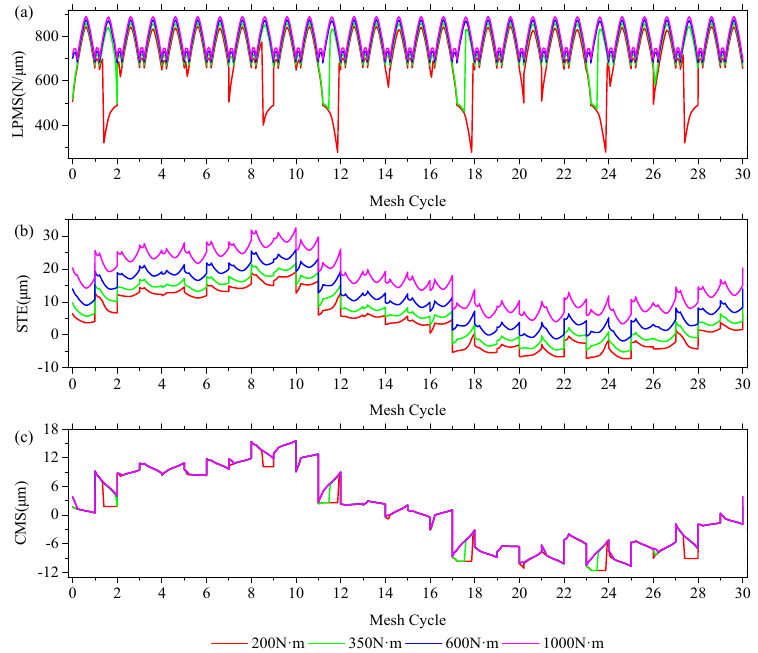
Figure 9. Long-period mesh stiffness (LPMS), static transmission error (STE), and composite mesh (CMS) at different load torques considering random cumulative pitch deviations.